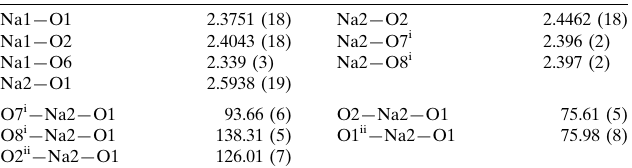
Selected geometric parameters (A˚ , (cid:5) ).